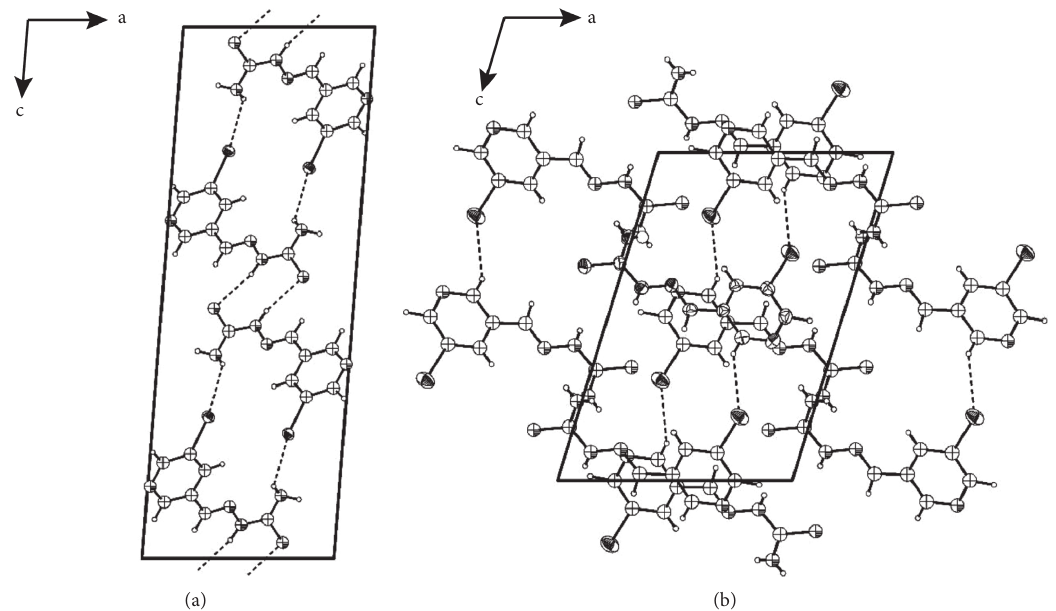
Figure 5: Packing diagrams of 7 in the rod-like (a) and plate-like (b)